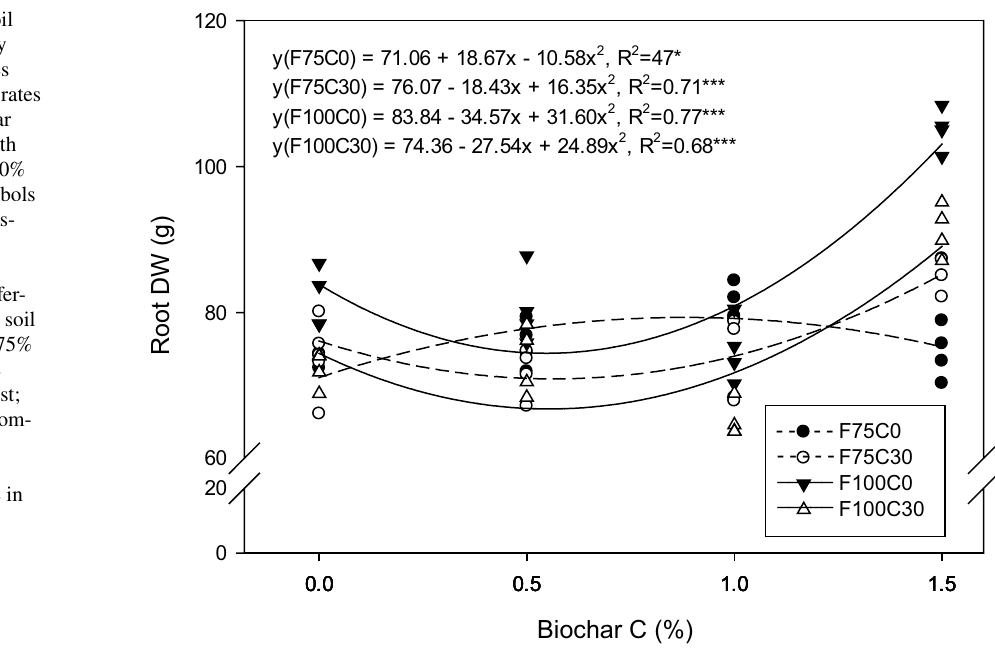
Fig. 3 Root dry weight of oil palm seedling as affected by fertiliser recommended rates (75 and 100%) and biochar rates (0, 0.5, 1.0 and 1.5% biochar C) in media without and with compost treatment (0 and 30% v/v compost). Asterisk symbols indicates a significant regres- sion trend at * P ≤ 0.05 and